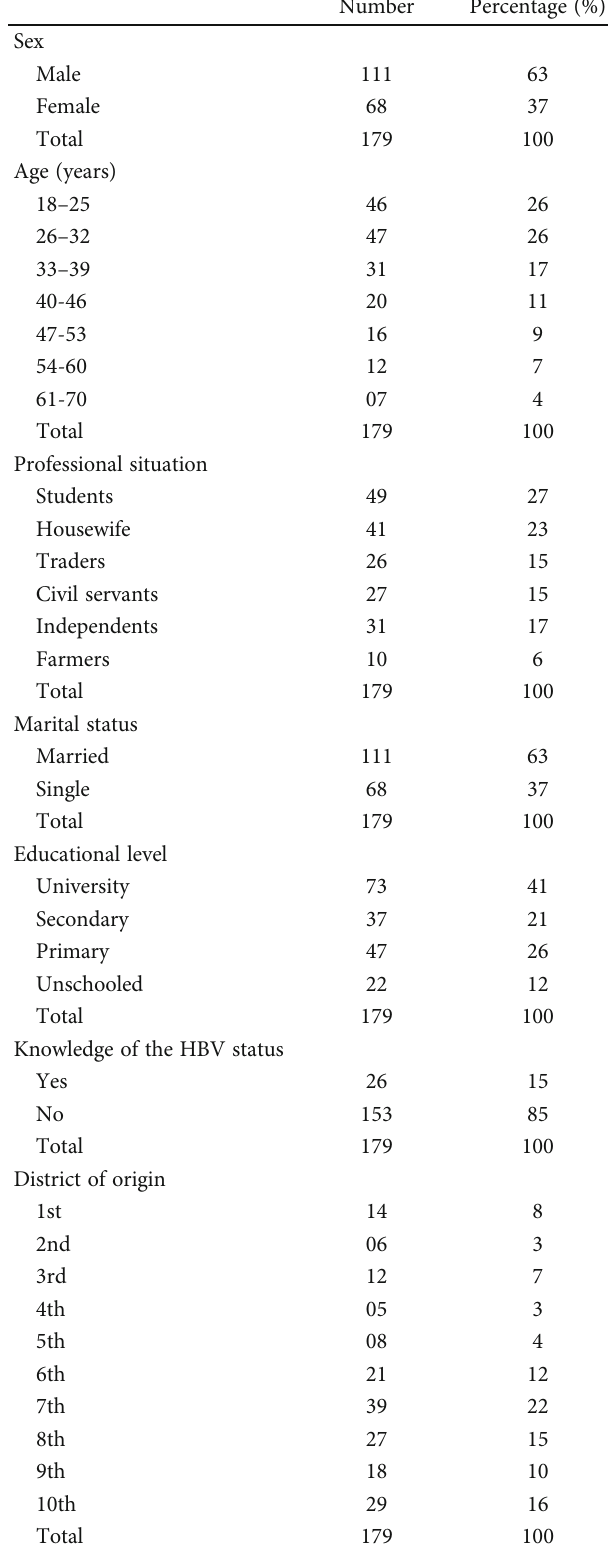
Table 1: Distribution of participants according to the sociodemographic